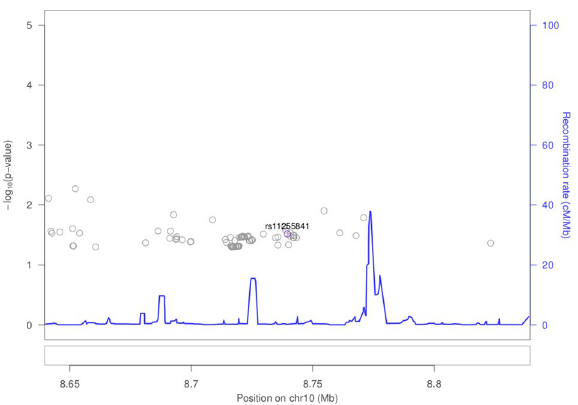
Figure 4. Association plot for 100 kb region flanking rs11255841 on chromsome 10.